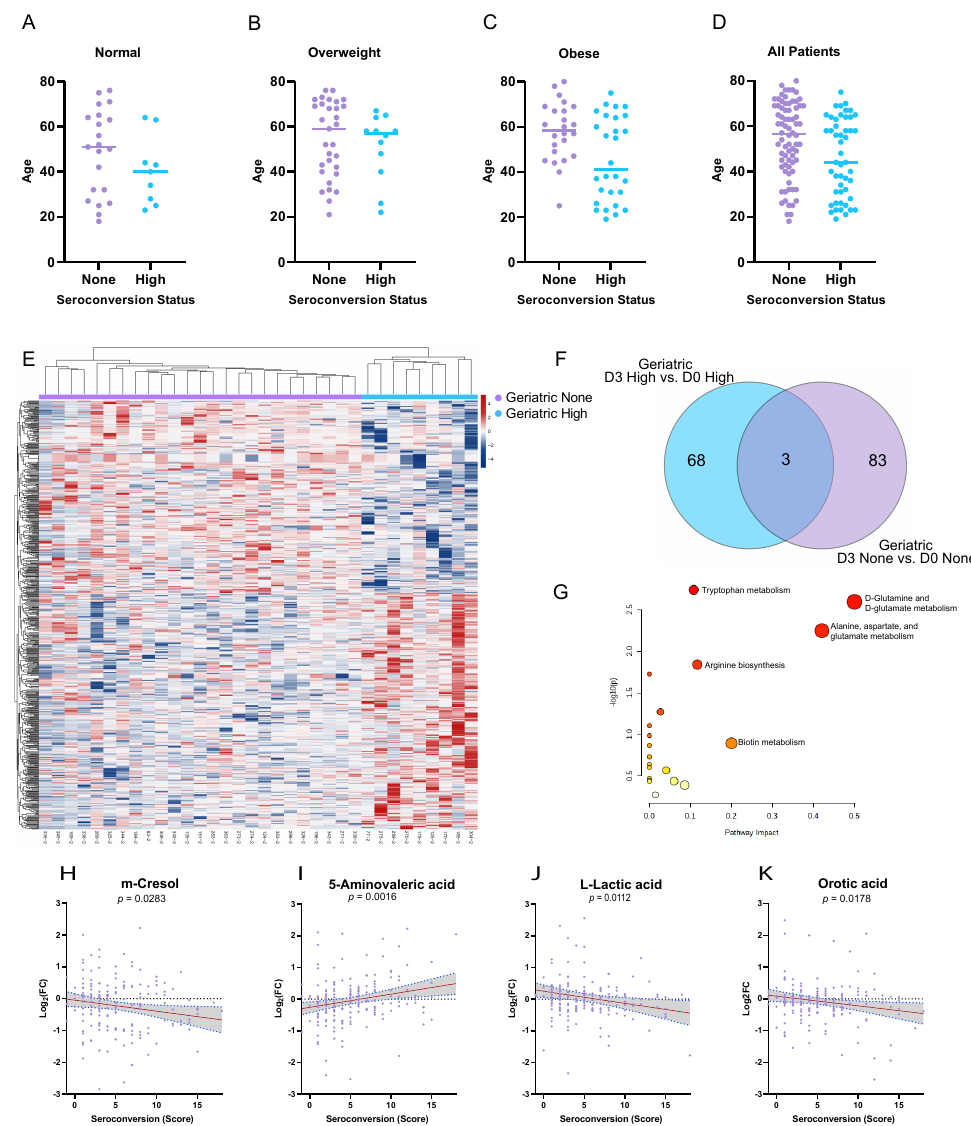
Figure 5. Differential metabolic profiles of geriatric High- and None-responders. ( A – D ) Scatter distribution of the ages of all the cohort subjects with respect to the BMI category. ( E ) Unsupervised hierarchical clustering of the metabolite profiles of geriatric High-responders and geriatric None- responders, with n = 624 putatively identified metabolites with a raw p -value of < 0.05 (t-test). ( F ) Venn diagram of overlapping significant metabolites between geriatric High-responders and geriatric None-responders on Day 3 (D3) and also on Day 0 (D0). ( G ) Metabolic pathway analysis of the uniquely changed metabolites among the geriatric None-responders. ( H – K ) Scatter plot correlations of the subject seroconversion score with the D3/D0 change in the relative metabolite levels. The red line represents the best-fit regression, and the grey area represents the 95% confidence interval for the line of regression, n = 179 for all the